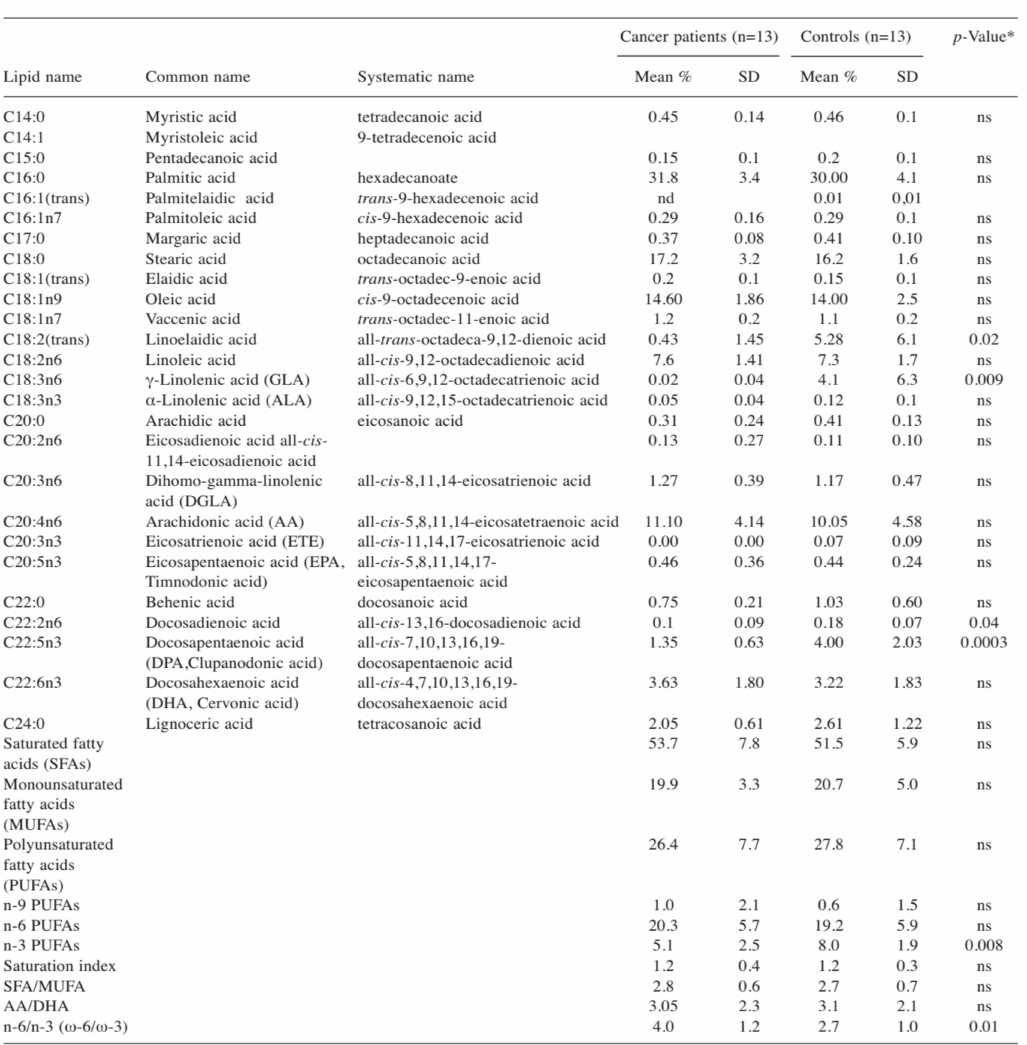
Figure 5. Mean percentage of the fatty acid composition of red blood cell membranes in cancer patients and controls (reproduced with permission from [61]). Mann-Whitney test, di ff erences were considered significant at p < 0.05; ns: no significant; nd: no